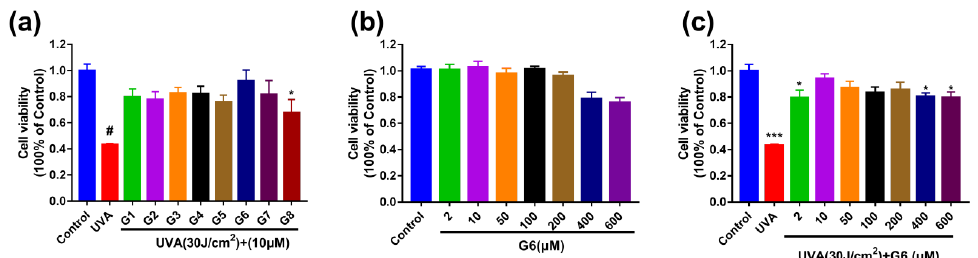
Figure 2. Effects of G6 on cytotoxicity of HaCaT cells determined using MTT assays. ( a ) The HaCaT cells were pretreated with 10 µ M G1–G8 for 48 h, and then irradiated with UVA (30 J / cm 2 ). ( b ) HaCaT cells were treated with 0, 2, 10, 50, 100, 200, 400, or 600 µ M G6 for 48 h. ( c ) The cells were pretreated with 0–600 µ M G6 for 48 h, and then irradiated with UVA (30 J / cm 2 ). Values are the mean of nine replicates ± S.E.M ( n = 9). Significant difference compared to the control group, * p < 0.05, *** p < 0.001 and # p < 0.0001.